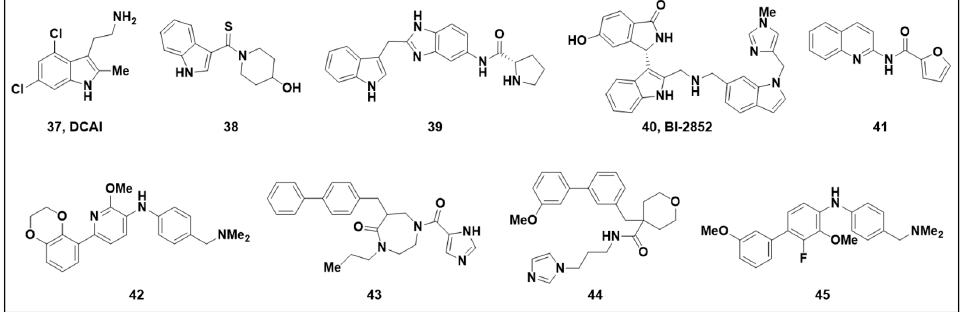
Figure 12. Structures of compounds ( 37 – 45 ).